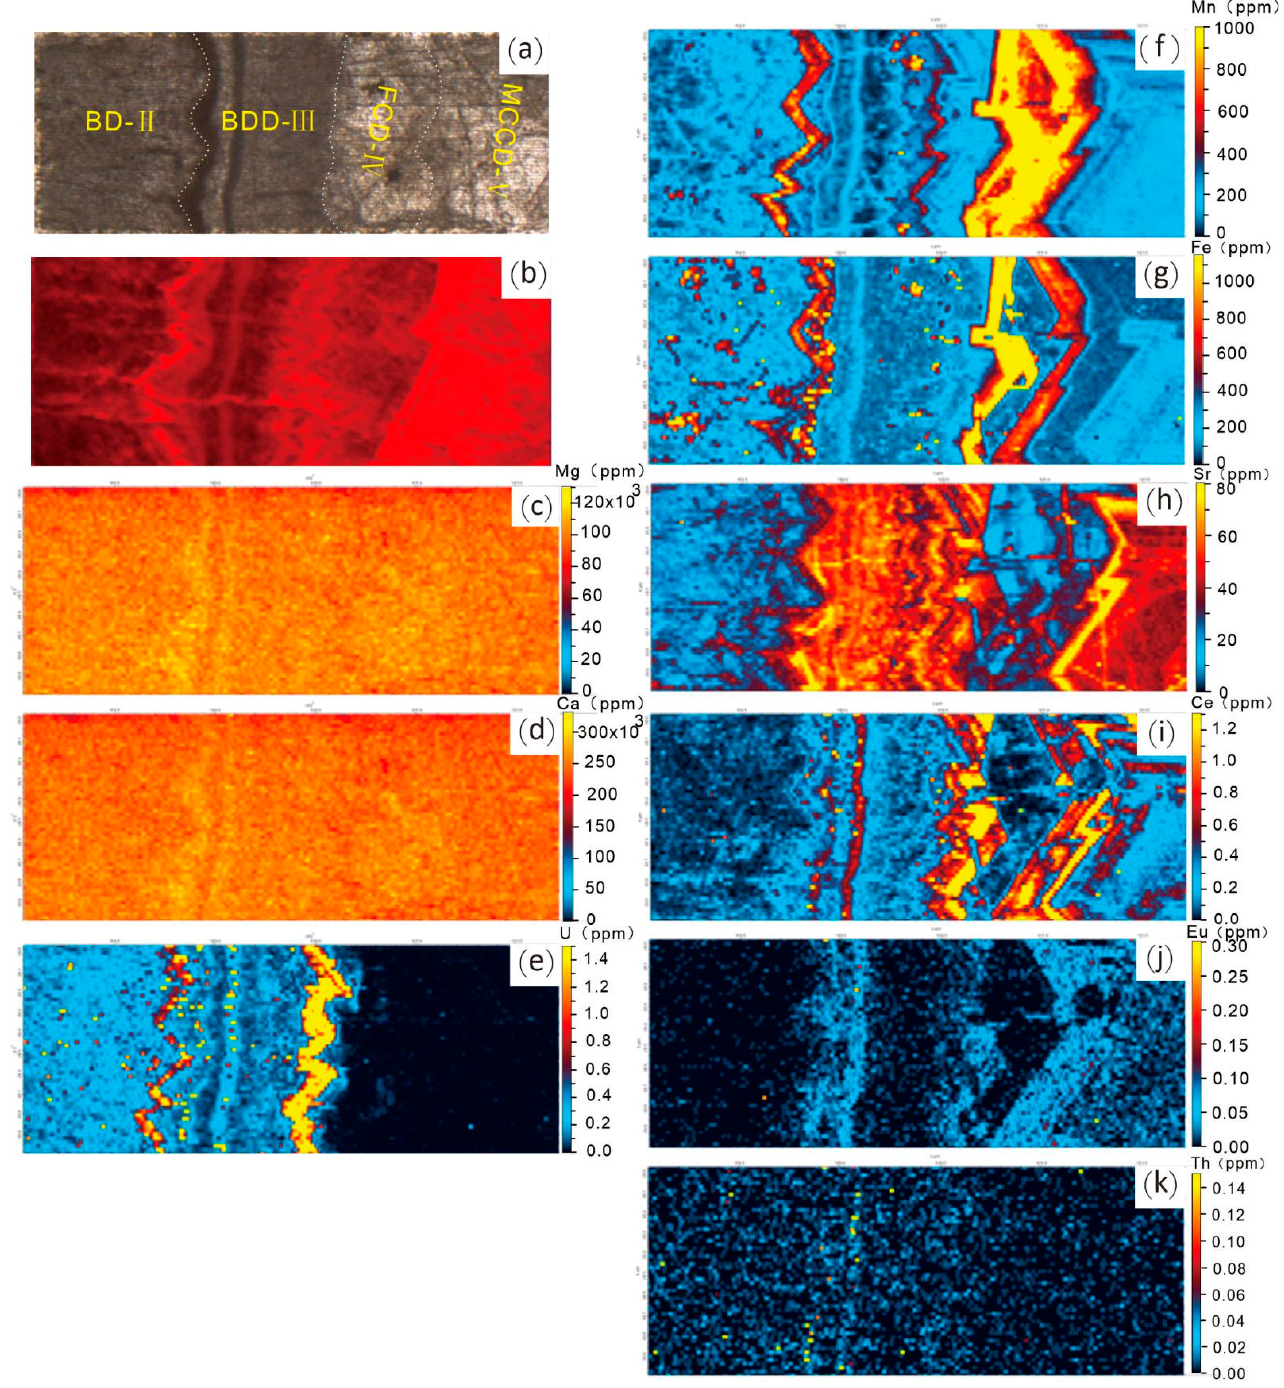
Figure 7. Elemental mapping of the botryoidal structure of sample HF-Dn1-1; ( a ) thin section image; ( b ) the CL image; ( c ) planar distribution of the Mg content; ( d ) planar distribution of the Ca content; ( e ) planar distribution of the U content; ( f ) planar distribution of the Mn content; ( g ) planar distribution of the Fe content; ( h ) planar distribution of the Sr content; ( i ) planar distribution of the Ce content; ( j ) planar distribution of the Eu content; ( k ) planar distribution of the Th content. The location of the mapping area is shown in Figure 5a.